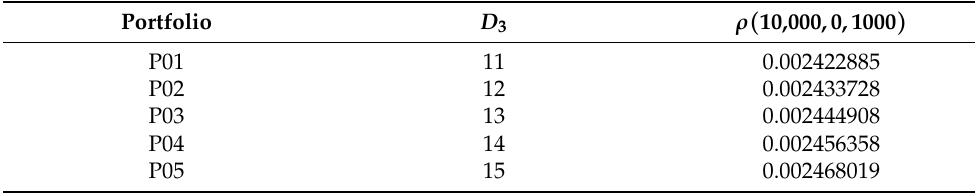
Table 7. Cases 2.2—Impact of the lifetime distribution on the risk